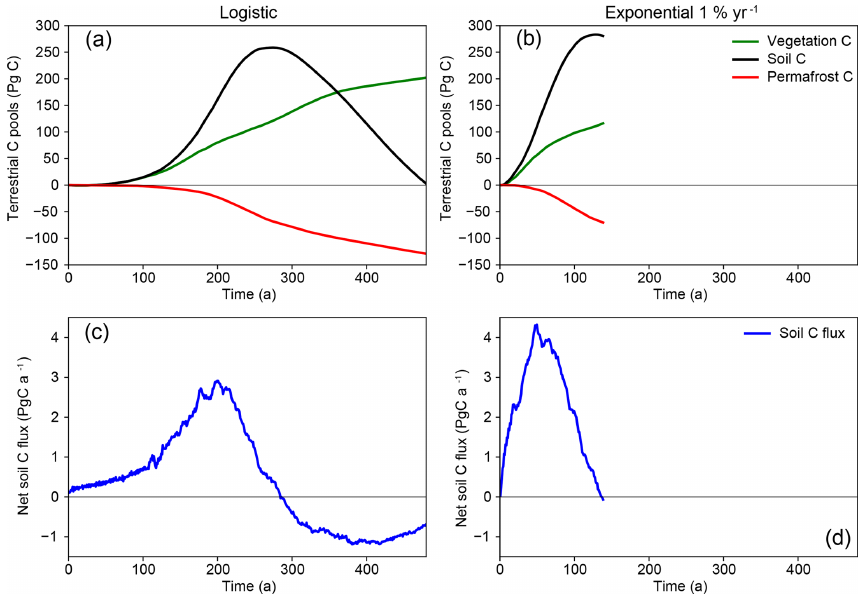
Figure 6. (a, b) Evolution of terrestrial carbon pool anomalies in the logistic and 1% experiments. (c, d) Flux of carbon into the soils computed from litter fall minus heterotrophic soil respiration (excluding the permafrost carbon pool). Note that in the logistic experiment the enhanced soil respiration feedback overwhelms the increased flux of litter from vegetation, leading soils to lose carbon – triggering a carbon sink-to-source transition on